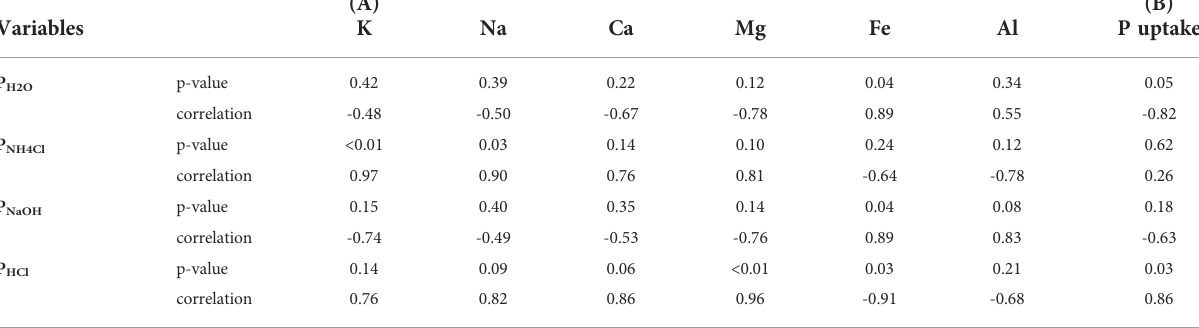
TABLE 2 Pearson ’ s correlation between sequentially extracted P with distilled deionized water (P H2O ), 1 M NH 4 Cl at pH 7 (P NH4Cl ), 0.1 M NaOH (P NaOH ), and 0.5 M HCl (P HCl ) from gB, gBM, cBM and cBS ashes with total mass fractions of potassium (K), sodium (Na), calcium (Ca), magnesium (Mg), iron (Fe) and aluminum (Al) in the ashes ( A ), and with phosphorus (P) uptake from the ashes ( B